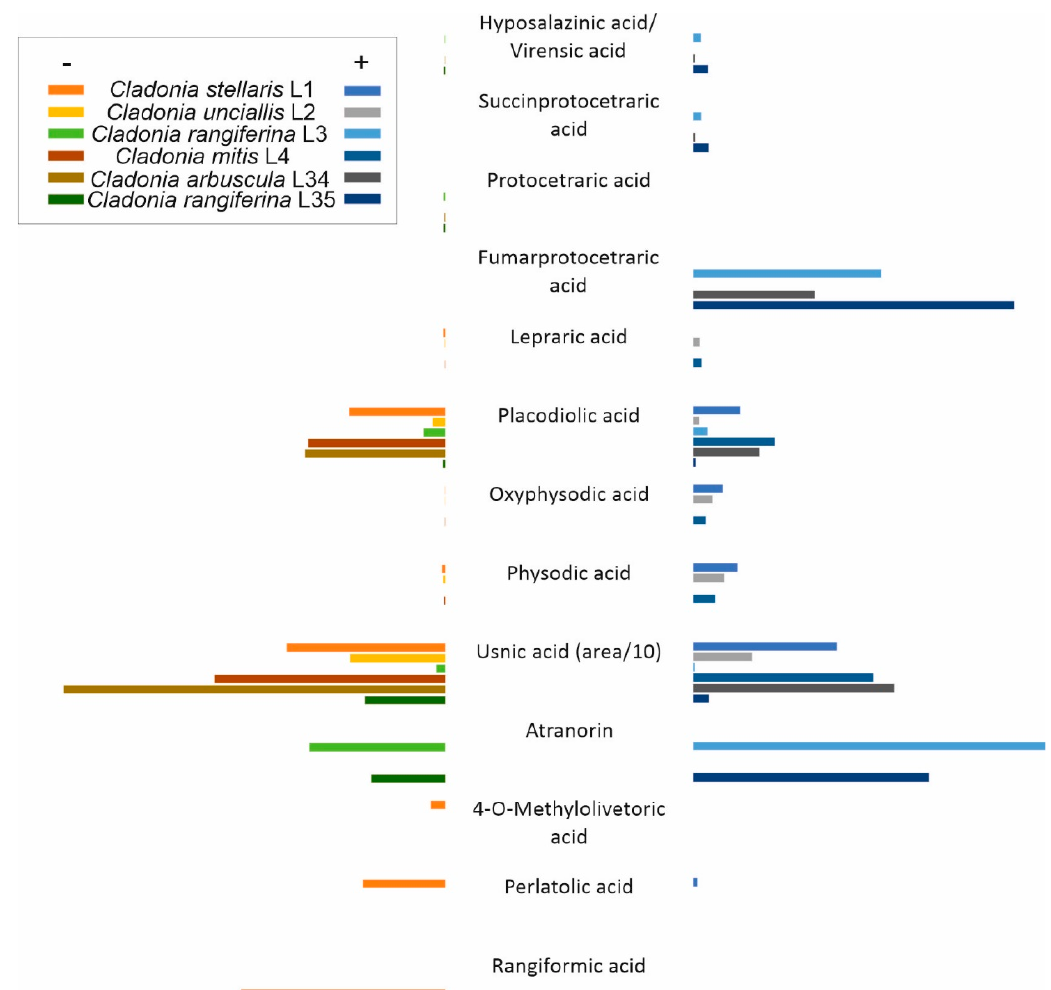
Figure 4. Relative amounts of lichen natural compounds fractionated by UPLC and identified by ESI-Q-TOF mass spectrometry. Compounds were detected using negative (left side of the figure, shown in yellow, orange, brown, and green bars) and/or positive (right side of the figure, shown in blue and gray bars) ionisation modes. Lichen extracts were obtained from specimens L1–L4, L34, and L35 kept at room temperature and extracted using acetone. Usnic acid was synthesised in higher amounts and the area value was divided by 10 to easily observe other compounds that were detected. Data visualised from Supplementary Table S8.